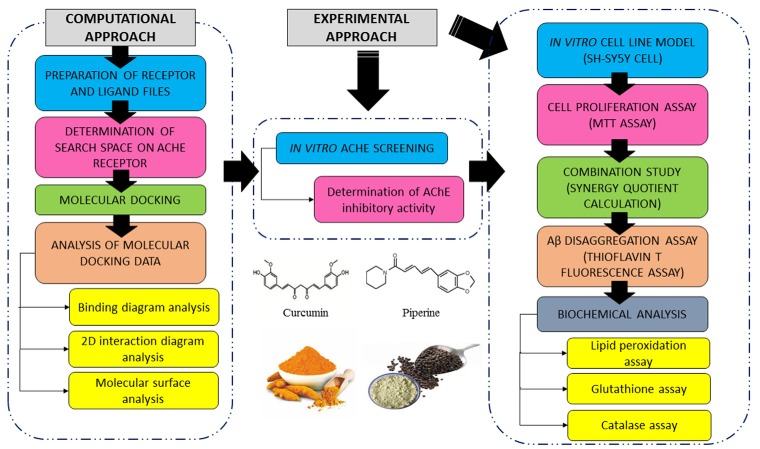
Summary of computational and experimental approach conducted in this study.